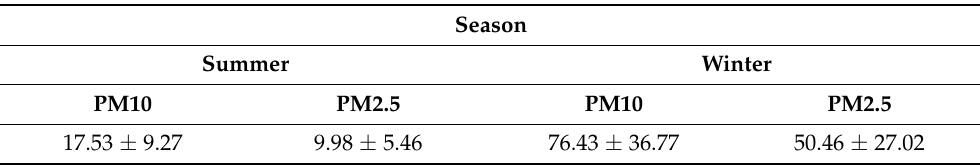
Table 2. Mean concentration of PM10 and PM2.5 (mean in µ g/m 3 ± SD) in the air of Cracow in the summer and wintertime between